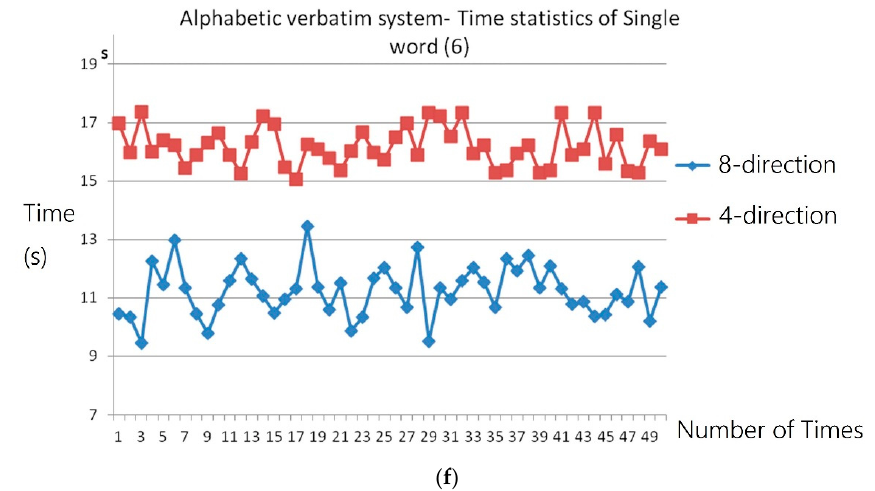
Figure 9. The test results of the numeric Chinese phonetic alphabet table with head ‐ control interface